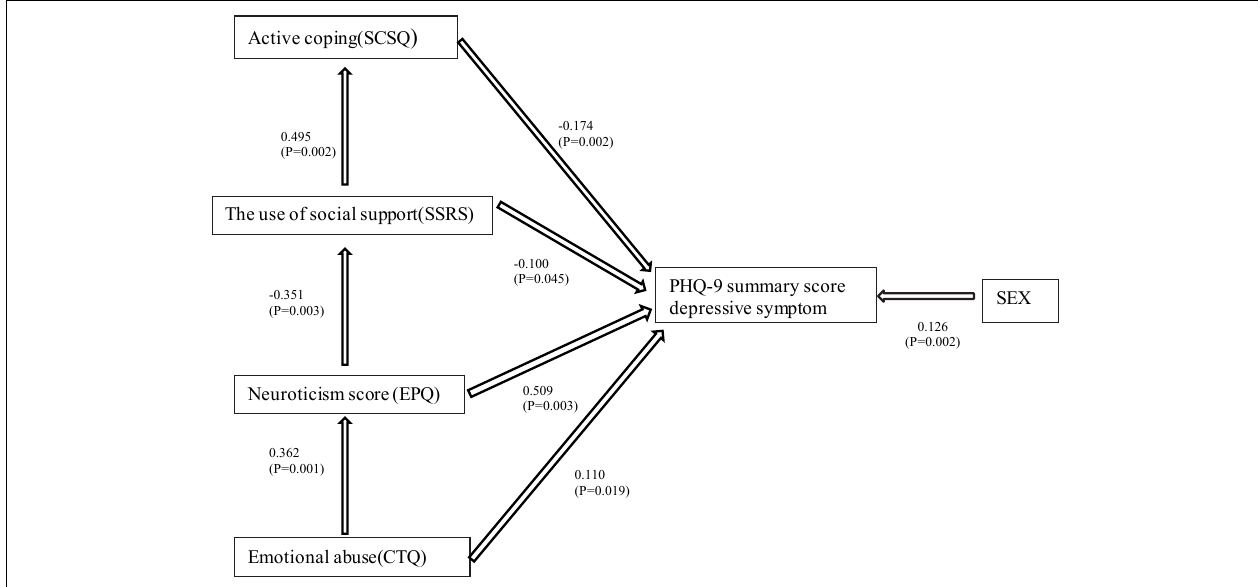
FIGURE 2 | Covariance structure analysis in 312 participants. The results of the covariance structure analysis in the SEM with EA (CTQ), neuroticism (EPQ), the use of social support (SSRS), active coping (SCSQ), and depressive symptoms (PHQ-9) in 312 participants from the general adult population. Rectangles indicate the observed variables. The arrows with double lines indicate the statistically significant effects. The numbers beside the arrows show the standardized path coefficients (–1 to + 1). CTQ, The Childhood Trauma Questionnaire; EPQ, Eysenck Personality Questionnaire; SSRS, The Social Support Rating Scale; SCSQ, Simplified